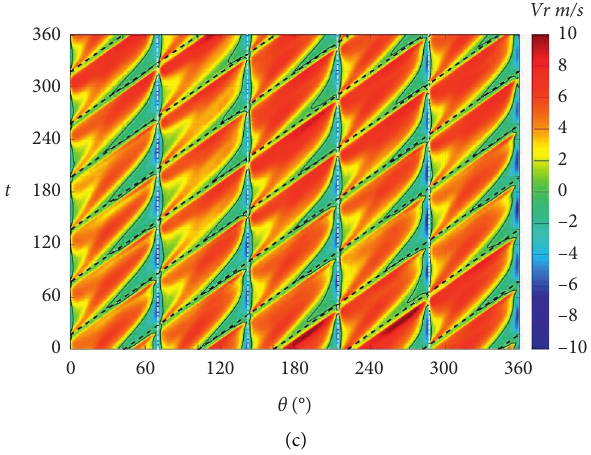
Figure 9: Radial velocity variation of impeller outlet in one cycle. (a) Span0.85. (b) Span0.5. (c) indicates the position of the guide vane blade, the black line